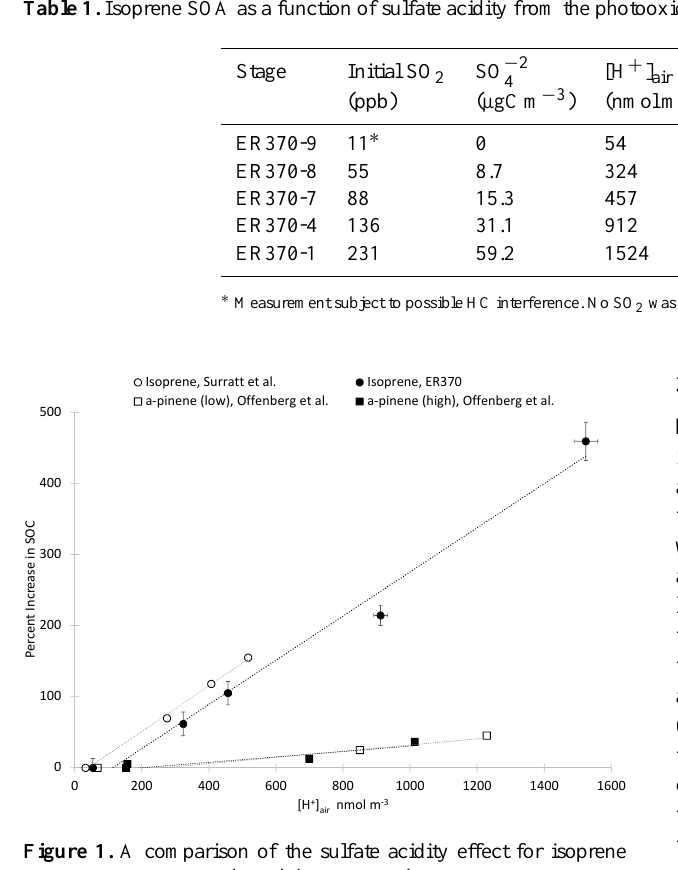
Figure 1. A comparison of the sulfate acidity effect for isoprene SOA. For Surratt et al. (2007) (open circles), the acidity was derived from nebulized sulfate aerosol. In the present study (closed circles), the acidity was derived from the photooxidation of SO 2